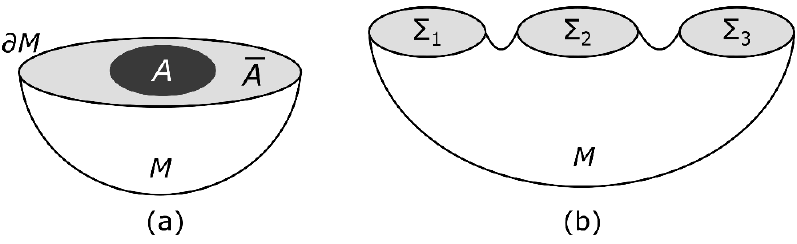
Figure 1 . Figure (a) shows a manifold with a single boundary @M which is partitioned into a sub-region A and its complement (cid:22) A . Figure (b) shows a manifold M whose boundary has three disconnected components, i.e. @M = (cid:6) 1 t (cid:6) 2 t (cid:6) 3